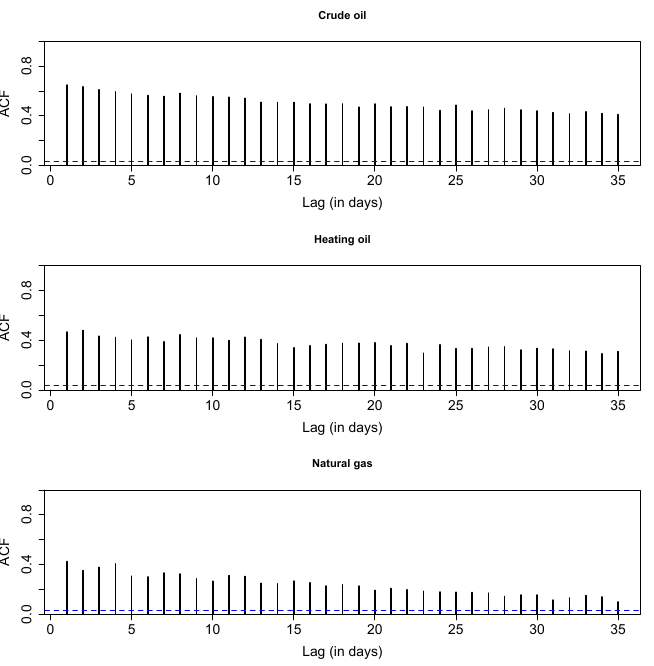
Figure 2. Autocorrelation functions. ACF denotes the autocorrelation function of the realized volatility of the returns of the prices of the respective metals. The dashed horizontal line denotes the 95% confidence line. The sample period is 3 January 2001–27 November